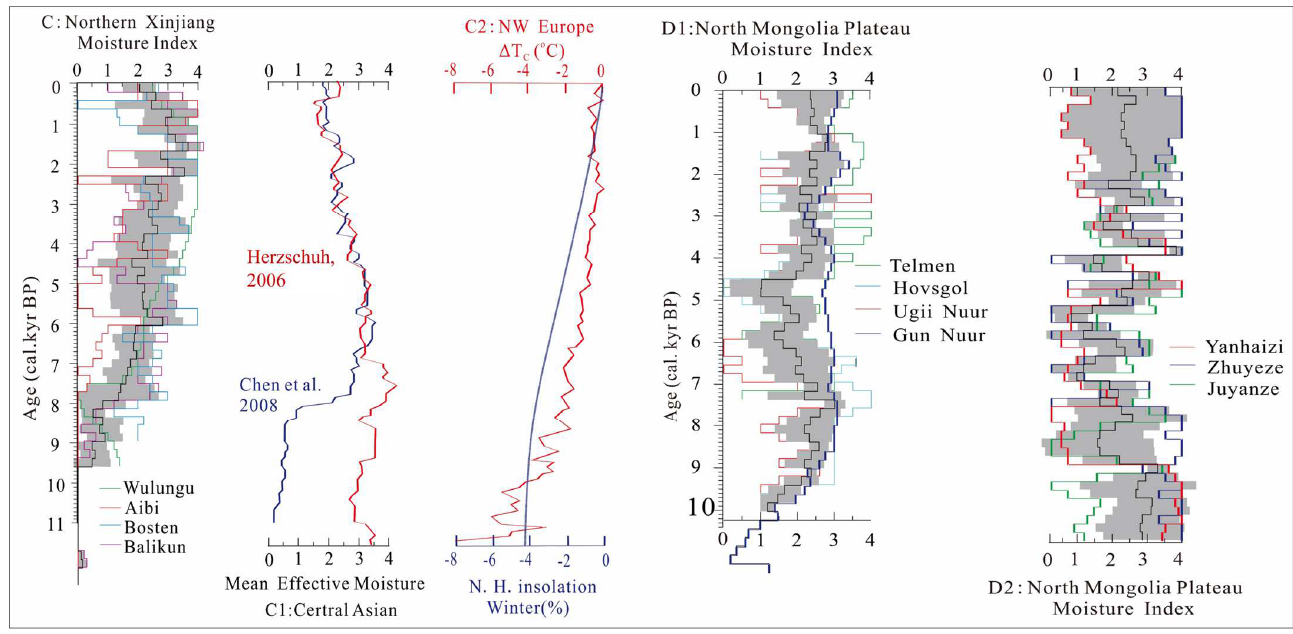
Figure 8. Comparison of humidity indices and related climate indicators in different regions of Central Asia (modified after [64]). The index from the northern part of Xinjiang (C) is compared with the average moisture index (C1) of Asian Central Area (ACA) by Chen F et al. (2008) [13], and Mean Effective Moisture index by Herzschuh (2006) [68], the cold-season temperature deviation (C2) in northern Europe [69], and the northern hemispheric winter insolation